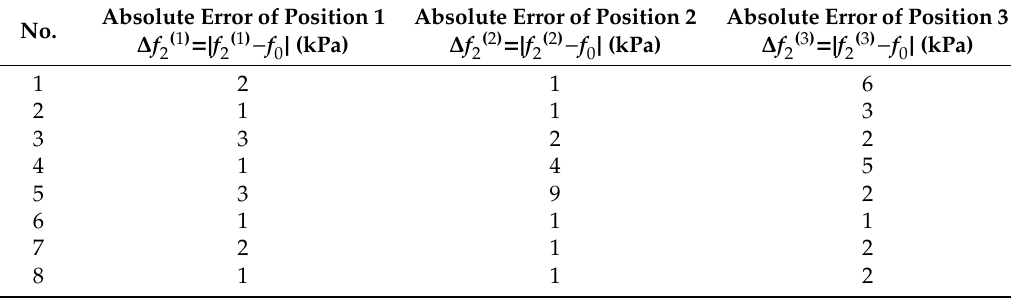
Table 7. Measurement absolute errors by the proposed